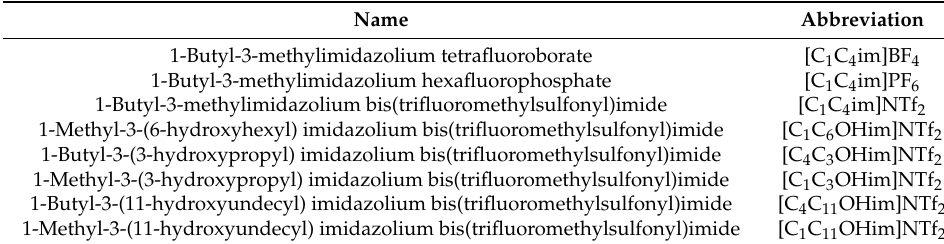
Table 1. Names and abbreviations of the ILs used in this